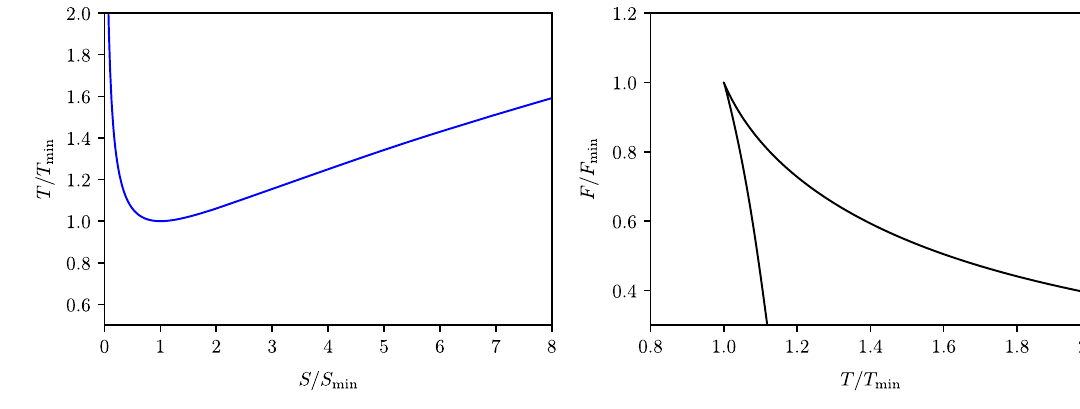
Fig. 2 T − S and F − T curves at J = 0